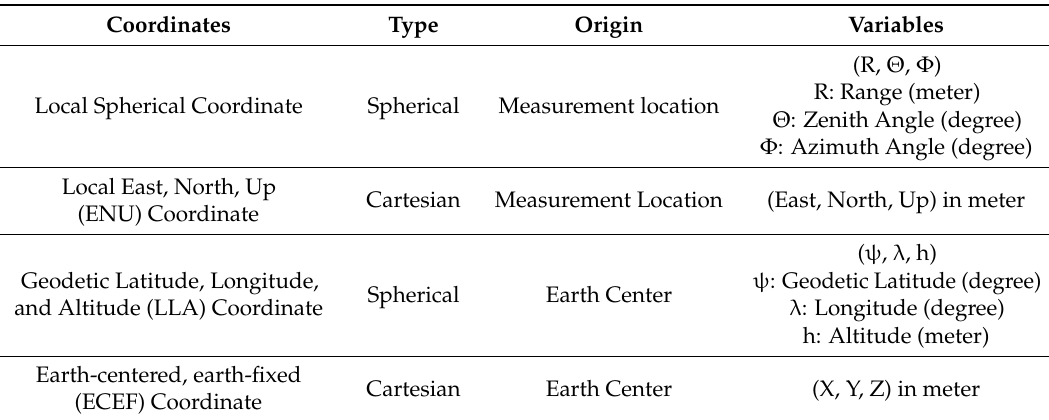
Table 1. Summary of coordinate systems used in this